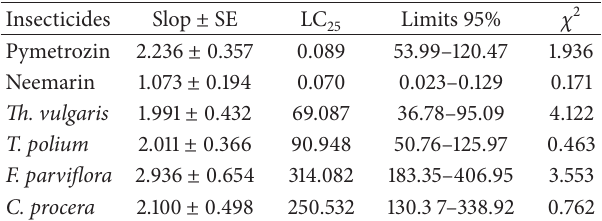
Table 1: The LC ratio (mg/mL), slop ± SE, lower and upper 25 95% confidence intervals, and 𝜒 2 of some synthetic and botanical insecticides on B. tabaci